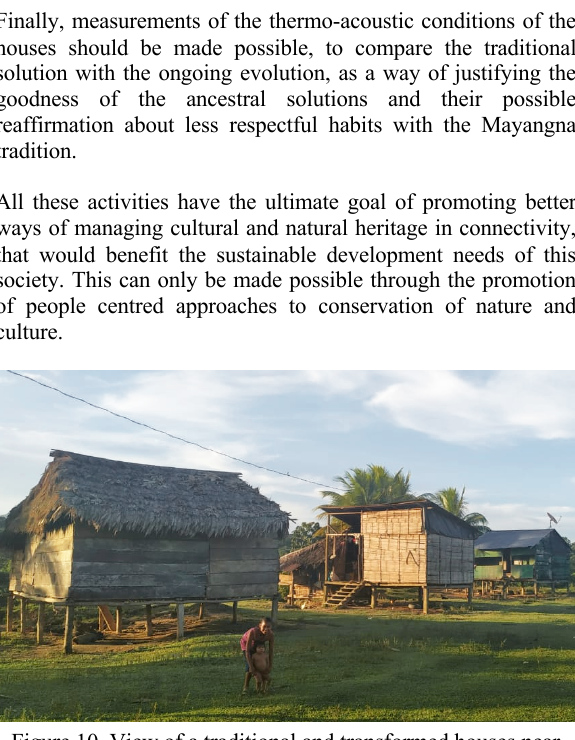
Figure 10. View of a traditional and transformed houses near Santa María, Bonanza. (Lic. Milena